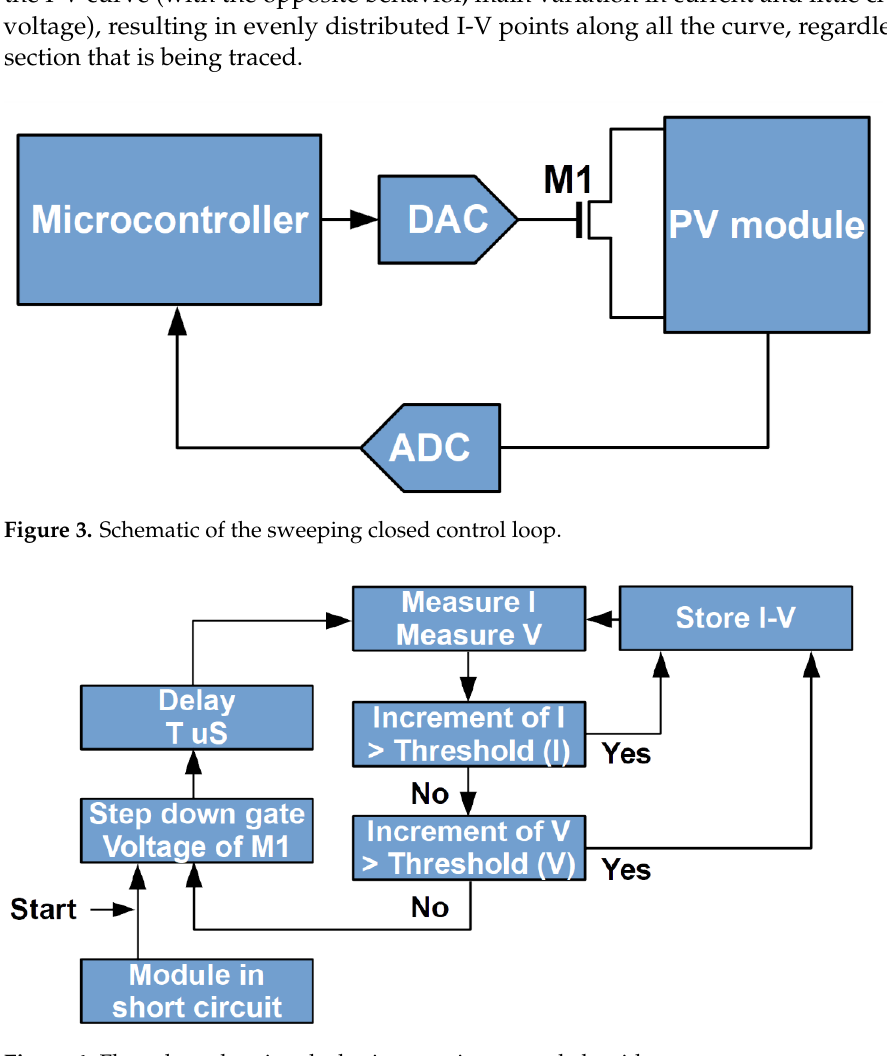
Figure 3. Schematic of the sweeping closed control